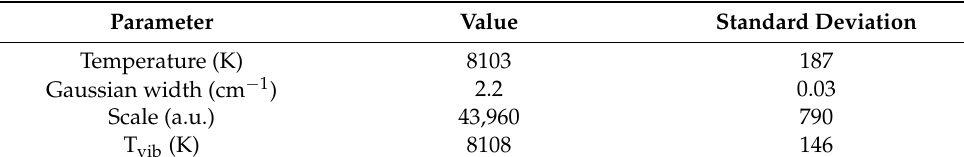
Table 4. PGOPHER fitting parameters for the 0.033 nm data and results.